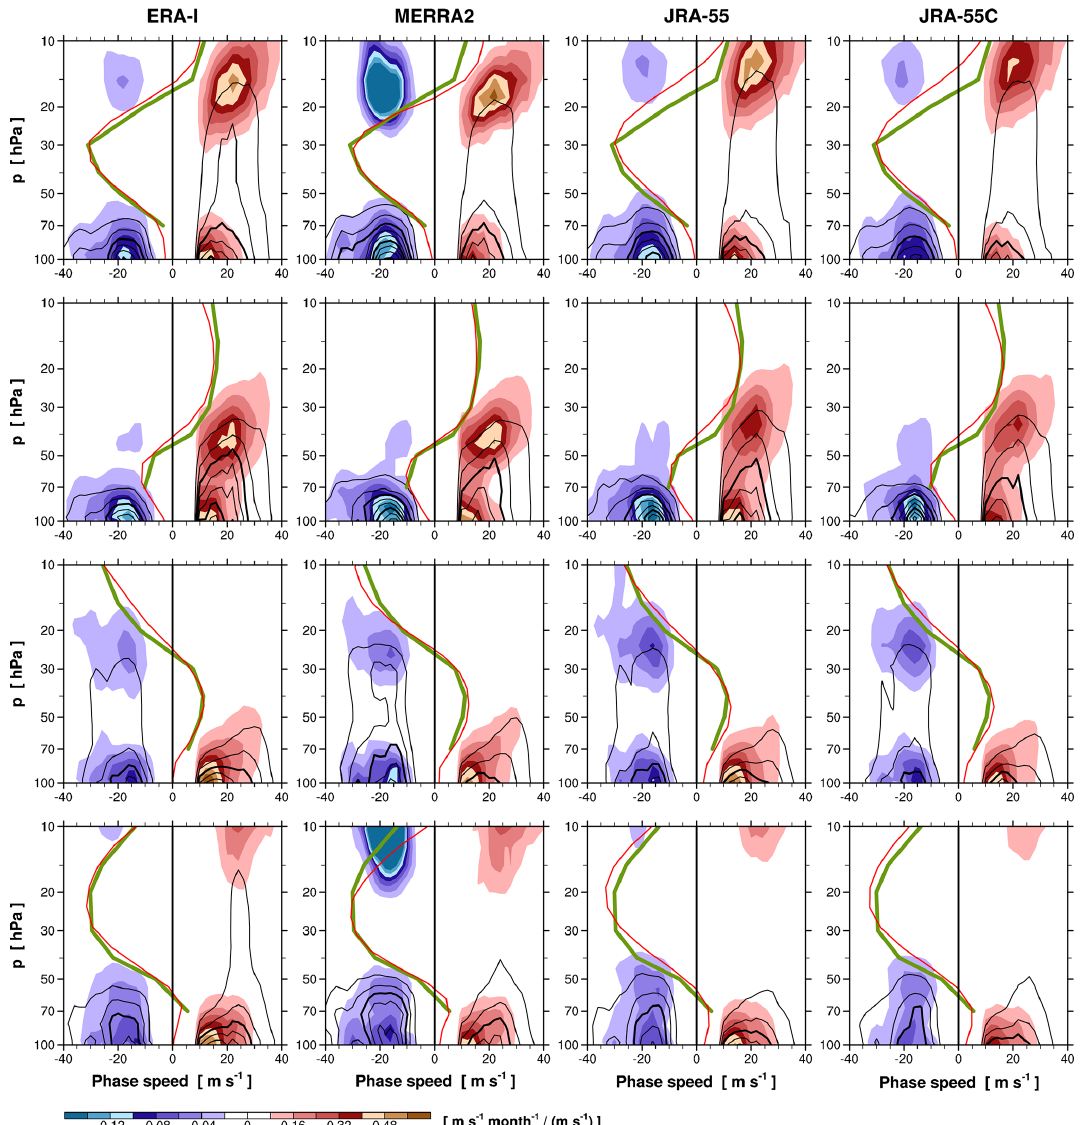
Figure 11. Vertical profiles of phase-speed spectra of the EP flux divergence (shading) and vertical EP flux (black contour) averaged over 5 ◦ N–5 ◦ S for the Kelvin waves at c > 0 and MRG waves at c < 0, composited for the QBO phases of maximum westerly tendencies at 20 and 50hPa (the first and second rows, respectively) and easterly tendencies at 20 and 50hPa (the third and last rows, respectively) within the period of 1981–2010, from the model-level datasets of ERA-I, MERRA-2, JRA-55, and JRA-55C. The zonal-wind profiles for those composites are also indicated using each reanalysis (thin red lines) and radiosonde observations (thick green lines; see the text for the composite method). The contour intervals of the EP flux are 0.008 and 0.0003mPa / (ms − 1 ) for the Kelvin and MRG waves, respectively, and every third contour is distinguished by thicker lines. Note that the contour interval of the EP flux divergence for the Kelvin waves is 4 times larger than that for the MRG